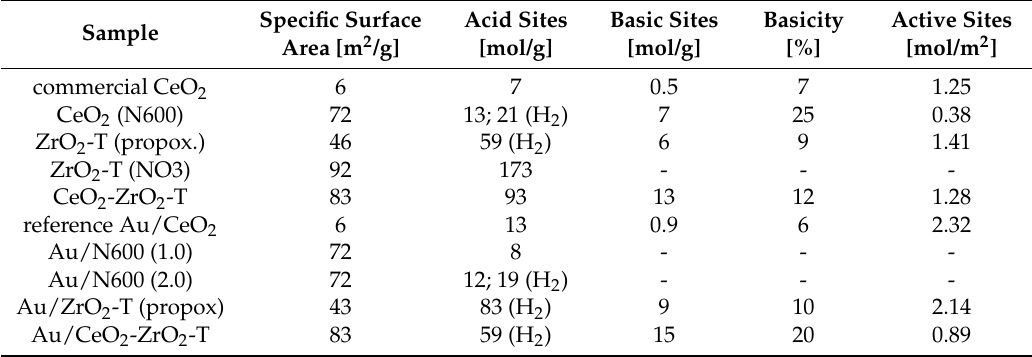
Table 3. Acid and basic properties of samples determined by NH 3 - and CO 2 -TPD.